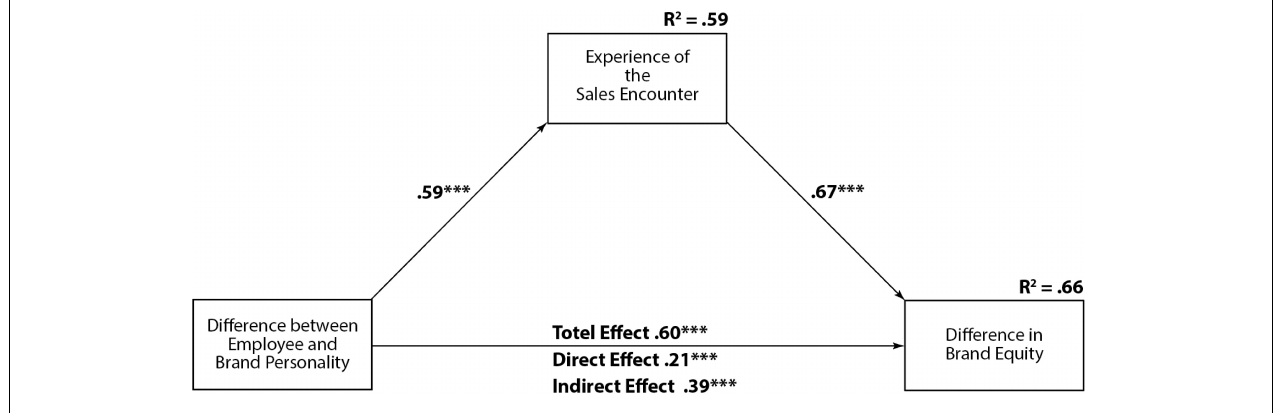
FIGURE 2 | Mediation model. *** p <